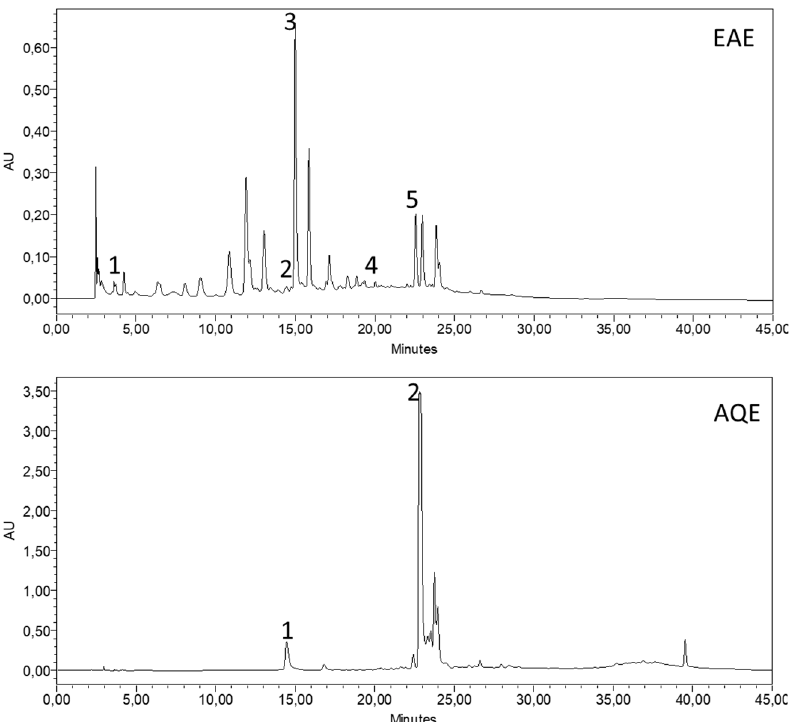
Figure 2. The HPLC chromatogram patterns of extracts from of A. absinthium : EAE (1) quercetin (1.29%), (2) p -hydroxybenzoic acid (0.21%), (3) caffeic acid (21.49%), (4) p -coumaric acid (0.77%), and (5) naringenin (5.85%); AQE (1) p -hydroxybenzoic acid (5.44%) and (2) naringenin (58.76%). EAE— ethyl acetate extract; AQE—aqueous extract.